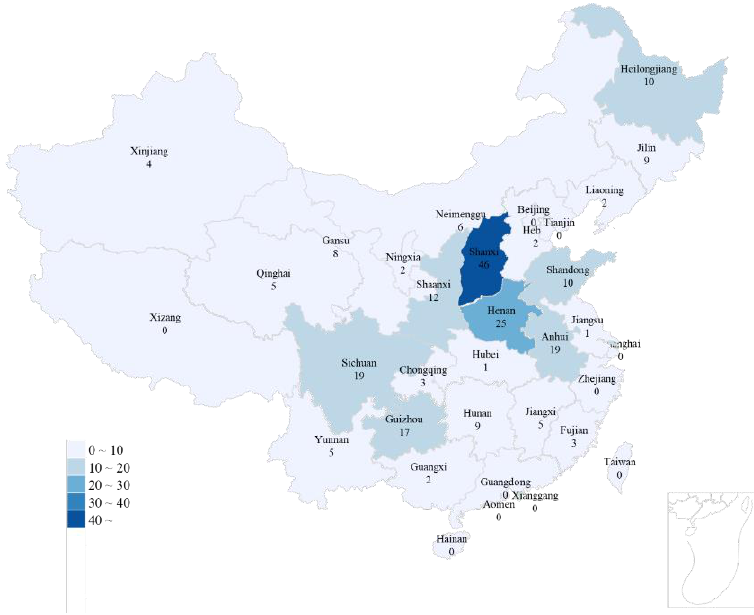
Figure 2. Accident quantity distribution map.